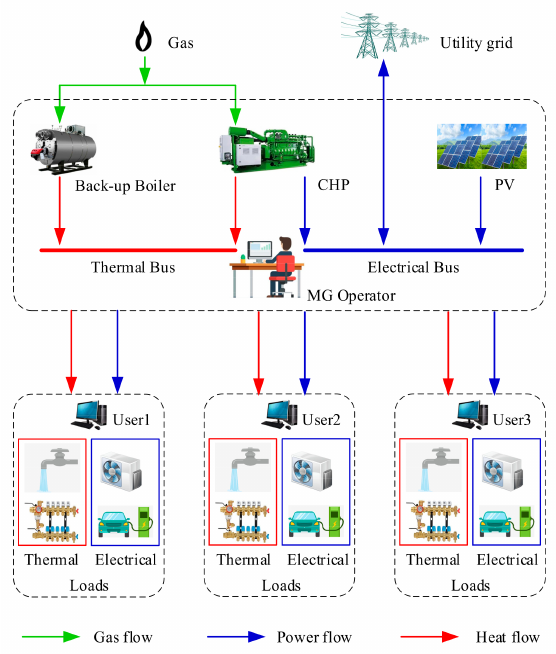
Figure 1. System